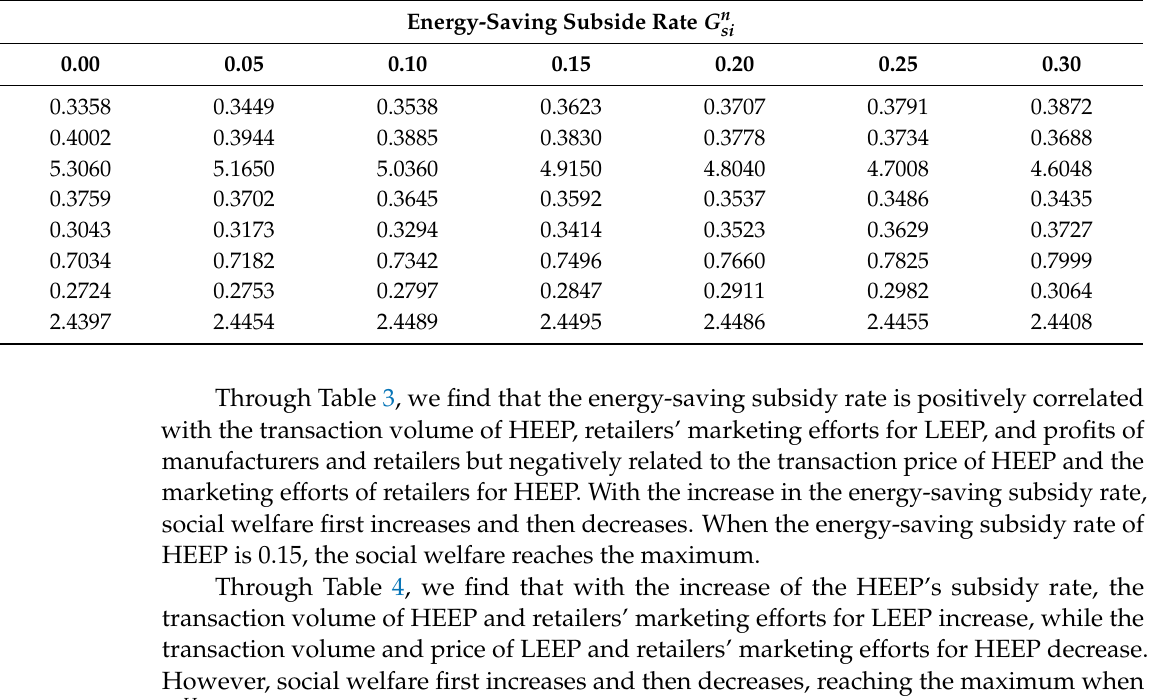
Table 4. The effect of G n on SCNE when the demand scales for HEEP and LEEP are different. si